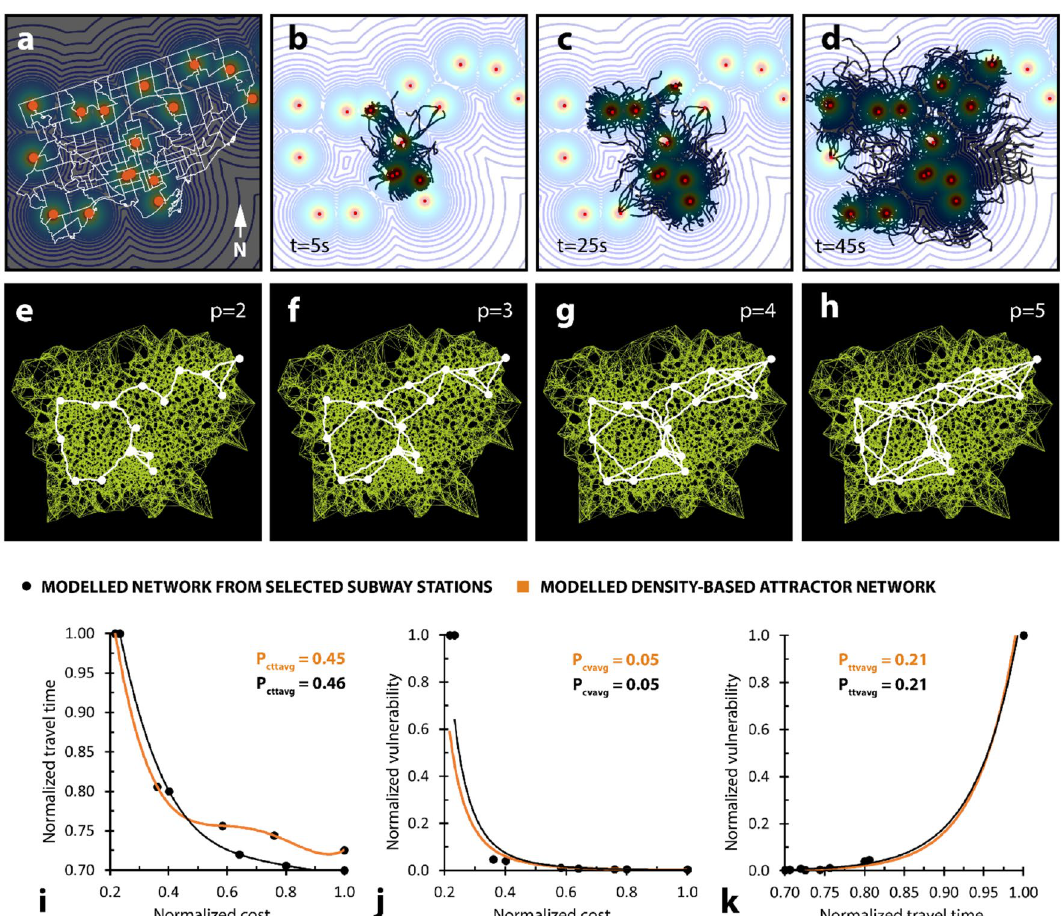
Figure 8. Comparison between modelled networks generated with population-density- and subway-station- defined attractor points. ( a ) Dot density population distribution of city of Toronto, where each dot represents 150,000 residents ( b – d ) Modelled growth to establish mesh to describe hypothetical subway system, based off attractors generated in a. ( e–h ) Different shortest-walk calculations for the same mesh, generated from d, but with unique proximity coefficient values. ( i ) Plot relating network cost to travel time for both density-based network model (orange) and station-based network model (black). Trendlines are both fourth-order polynomial functions. ( j ) Plot relating network cost to vulnerability for both density-based network model (orange) and station-based network model (black). Trendlines are both power functions. ( k ) Plot relating network travel time to vulnerability for both density-based network model (orange) and station-based network model (black). Trendlines are both exponential functions. All performance values normalized to the largest local value. Modelled average performance values displayed on the plots represent average performance values cross all network